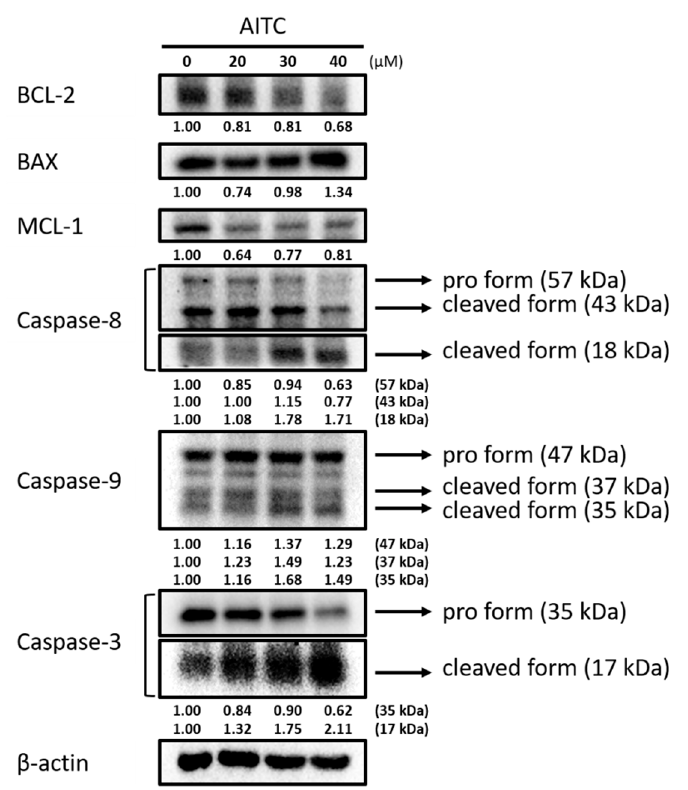
Figure 2. AITC affected apoptosis-associated protein expression in GBM8401/ luc2 cells. Cells (1.6 × 10 6 cells) were treated with 0, 20, 30, and 40 µM of AITC for 48 h. Cells were harvested for examining apoptosis-associated protein expression evaluation by Western blotting as described in the Materi- als and Methods. Each treatment was replicated 3 times with 3 independent